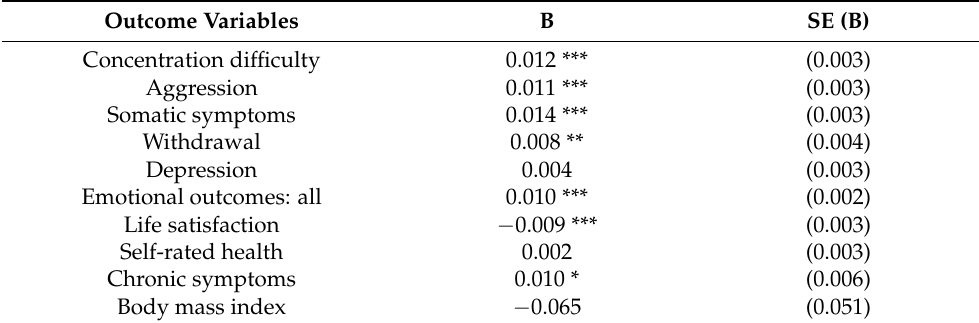
Table 2. Mixed effects regression analyses of health-related outcomes and emotional symptoms with weekday-to-weekend sleep duration